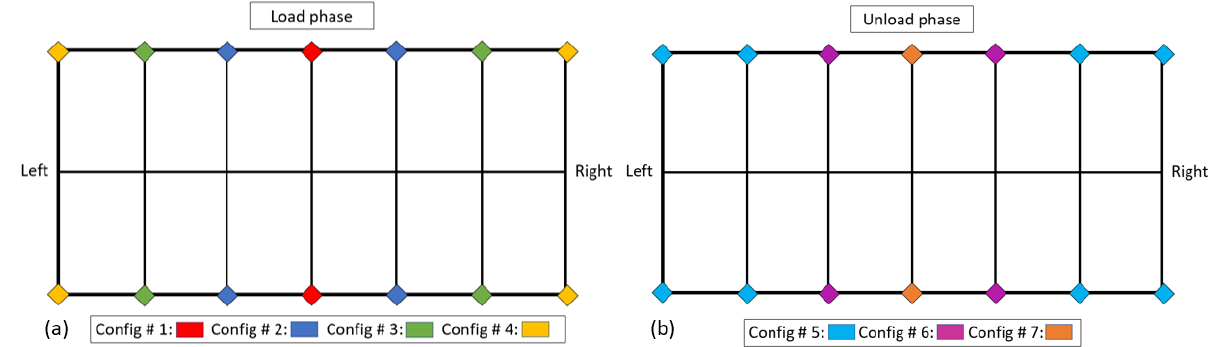
Figure 16. ( a ) Load phase configurations—( b ) unload phase configurations.